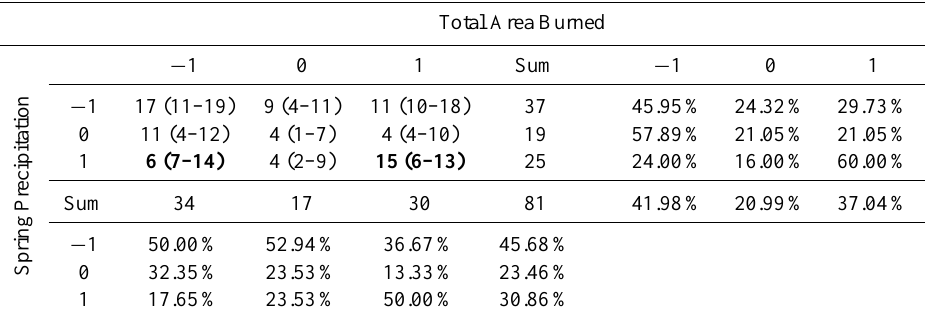
Table 6. Cross-tabulation results between the total area burned and spring precipitation. The Monte Carlo randomization confidence limits are noted in parentheses. Values in bold are statistically